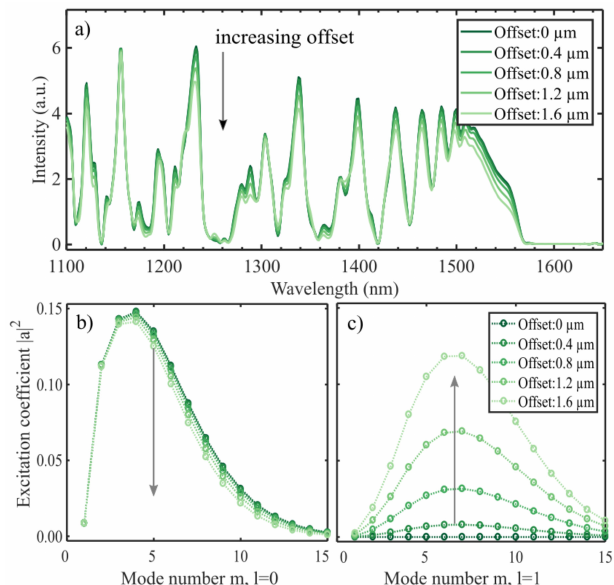
Figure 7. The output spectra for a 14.2 mm CL interferometer for moderate splice o ff sets ( a ). The peak intensities are in general reduced, whereas dips remain mostly unchanged. The excitation coe ffi cients ( b , c ) are calculated at the splice between the SMF and the CL fiber (Equation (3)) for l = 0 and l = 1. With a larger o ff set more power is going into the azimuthal modes ( c